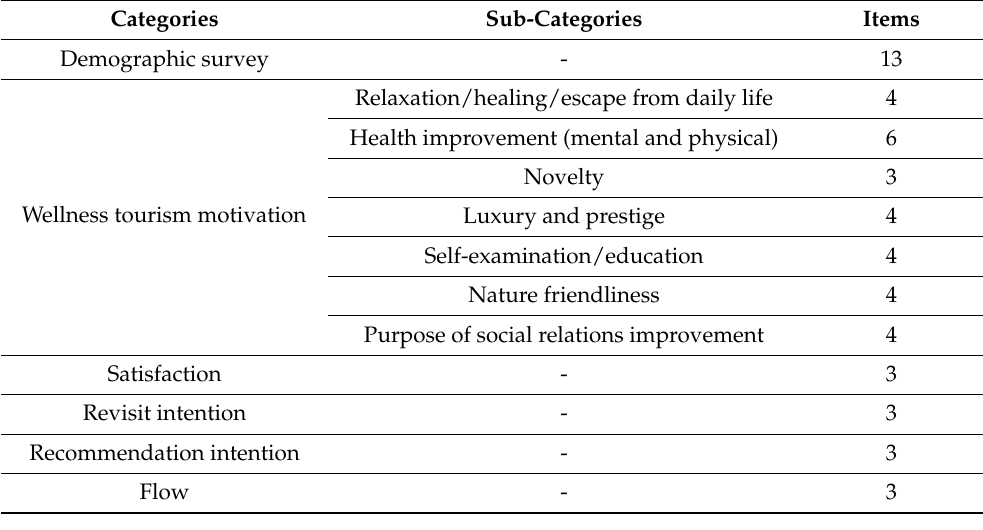
Table 4. Composition of study